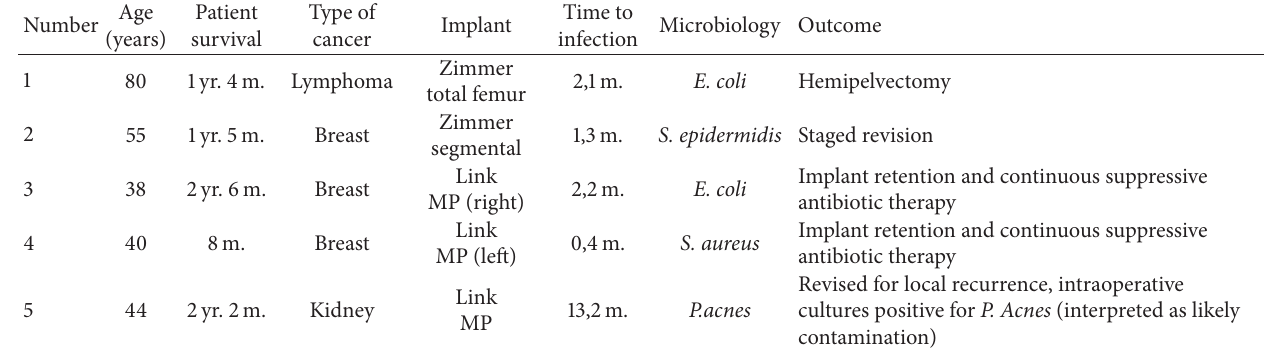
Table 2: Cases with positive deep tissue